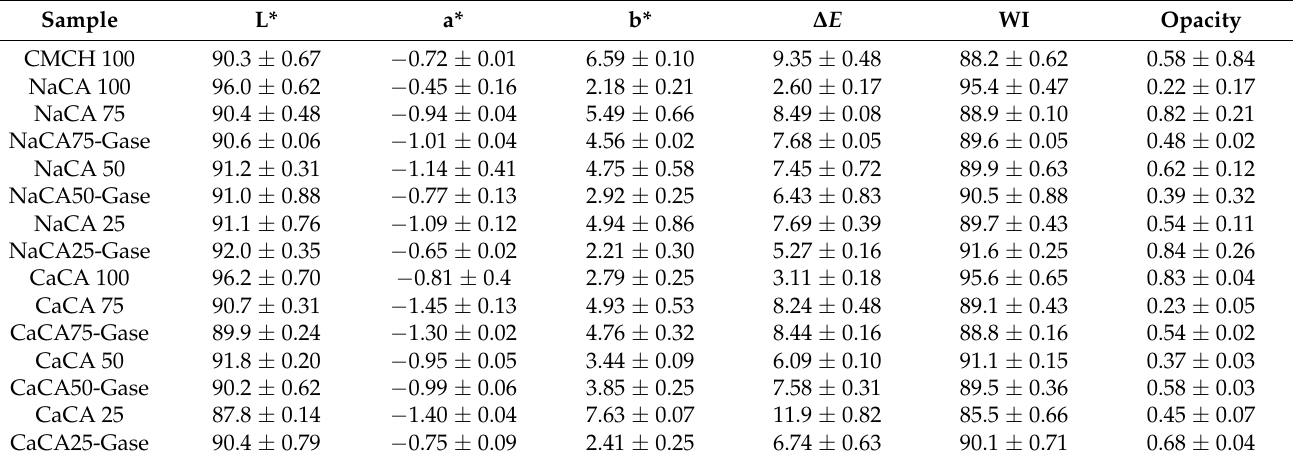
Table 2. L-a-b color parameters, total color difference, and whiteness index of edible